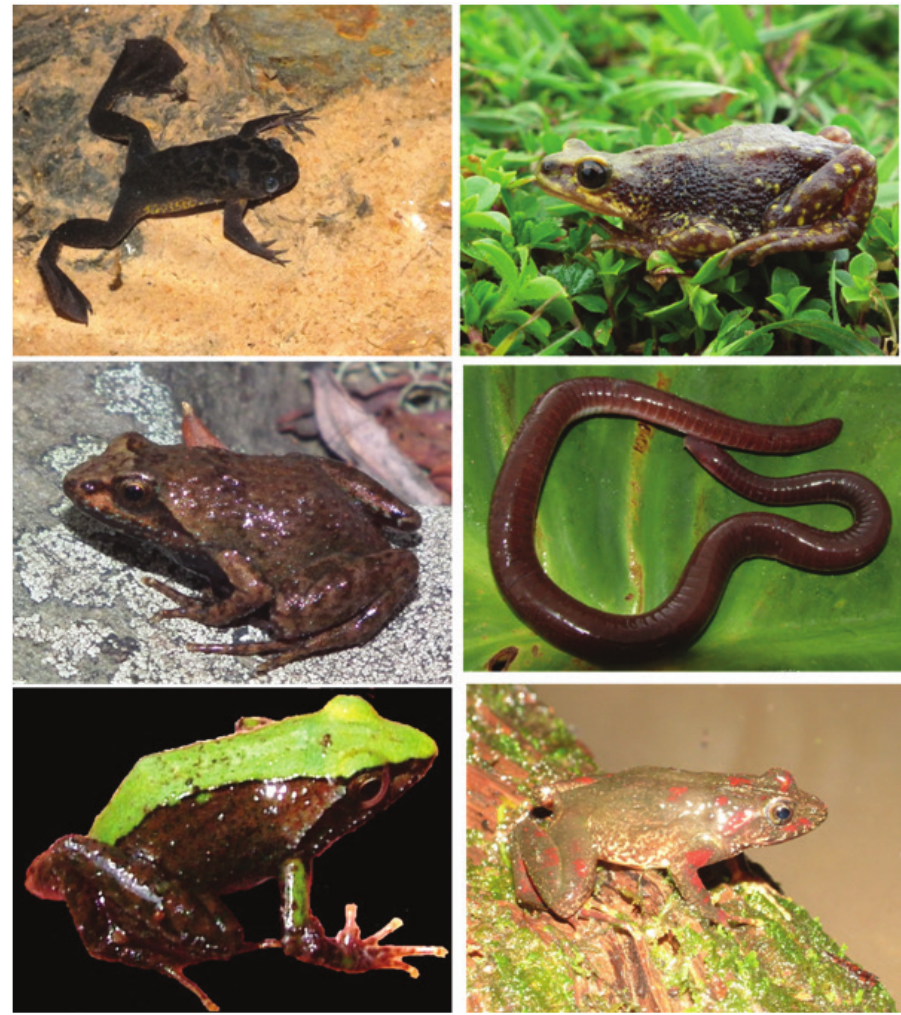
Figure 2. Endemic amphibians of Mt Oku. Clockwise from top-left: Lake Oku Clawed Frog, Xenopus longipes ; Mount Oku Subalpine Toad, Wolterstorffina chirioi ; Mount Oku caecilian Crotaphatrema lam- ottei ; Lake Oku Puddle Frog, Phrynobatrachus njiomock found almost exclusively in forest around Lake Oku; Puddle Frog Phrynobatrachus sp. aff. werneri ; Spiny Puddle Frog, Phrynobatrachus chukuchuku .